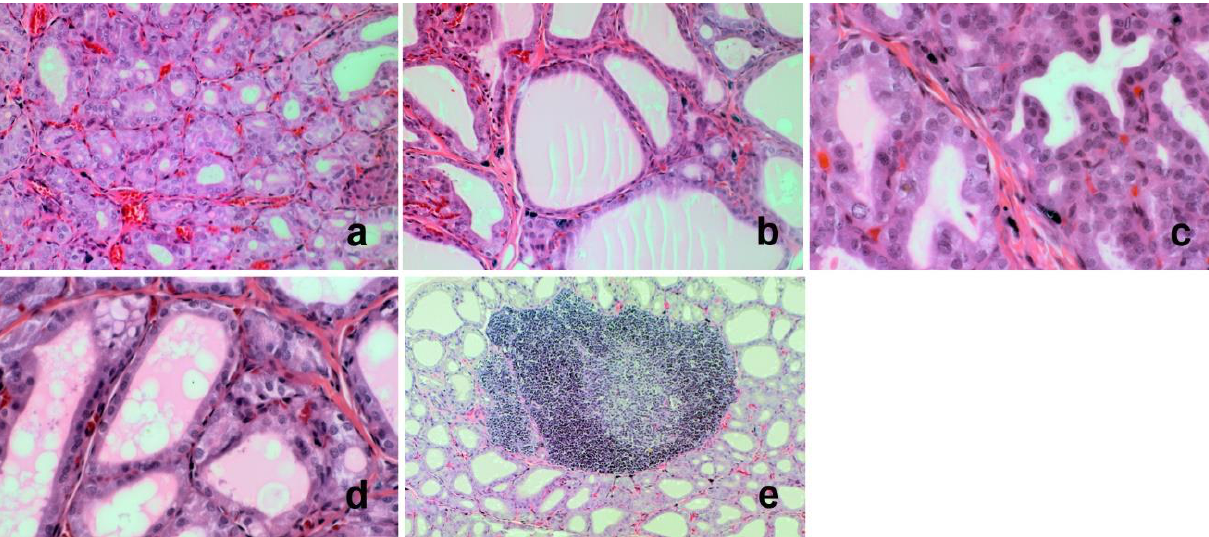
Figure 1. Histopathology of selected rat thyroid glands: ( a ) Cuboidal follicular epithelial cells lining small follicles. Haematoxylin and Eosin (H + E) original magnification 200×. ( b ) Flattened follicular epithelial cells lining larger follicles. H + E original magnification 200×. ( c ) Few small papillary projections of follicular epithelial cells protruding into the lumina of the follicles. H + E original magnification 400×. ( d ) Vacuolation of the colloid. H + E original magnification 400×. ( e ) Lymphoid follicles. H + E original magnification 400×.